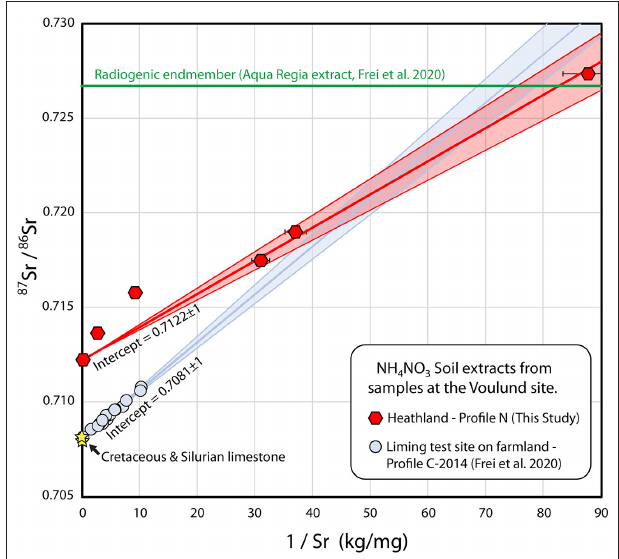
FIGURE 6 | Strontium mixing diagram with Sr isotopic compositions of ammonium nitrate leachates from Voulund soils as a function of the reciprocal Sr concentrations. Samples from soil profile N (heathland), this study, are shown as red hexagons, and samples from soil profile C—liming test site (Frei et al., 2020a), are shown as light blue circles. Also shown is the aqua regia extract of the deepest meltwater sand sample from Profile C in 2014, Frei et al. (2020a) (shown as a green line), as the Sr concentration of this is not directly comparable to the ammonium nitrate leachate samples. The compositions of the Cretaceous limestone that sources agricultural lime, and the Silurian limestone, sporadically found locally in the glacial outwash sands are shown as yellow stars. Regression lines were calculated with IsoplotR ( Vermeesch, 2018), and shaded areas indicate 2 σ uncertainty envelopes.